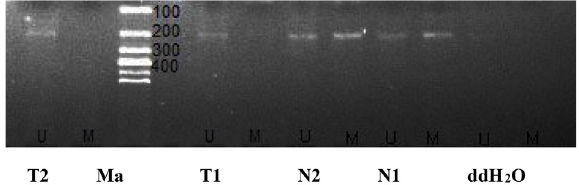
Figure 1. HPSE Gene Promoter Hypomethylation in BC and Normal Control Checked by MSP. Note. HPSE: Heparanase; BC: Bladder cancer; MSP: Methylation-specific polymerase chain reaction. T1-T2: BC samples; N1-N2: Normal bladder samples; Ma: Marker (100 bp DNA bladder); M: Methylated; U: